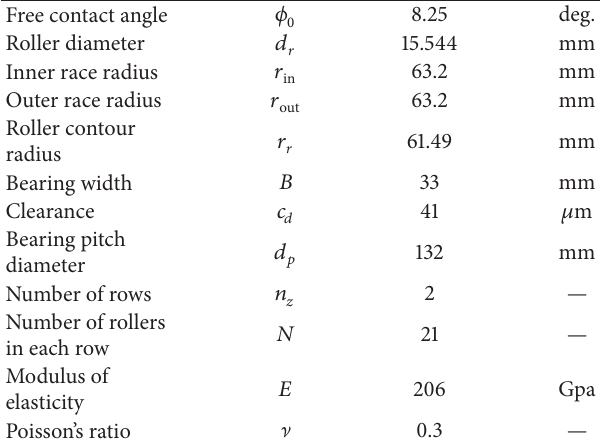
Table 1: Geometric parameters and material properties of bearing,